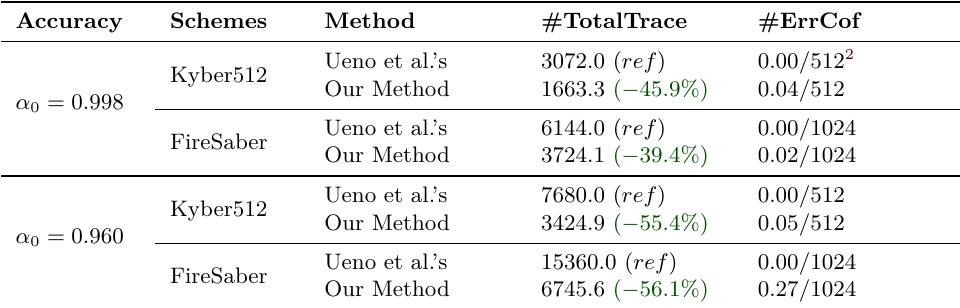
Table 8: Comparisons between Ueno et al.’s work and our proposed method for full-key recovery under O